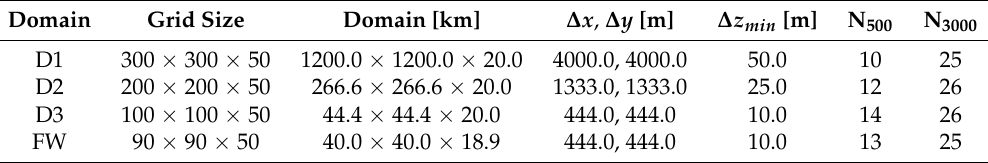
Table 1. ARPS nested grid configurations (domains D1, D2, and D3) and FLEXPART-WRF grid configuration (domain FW), with dimensions (excluding boundary points). ∆ x and ∆ y are the horizontal grid spacing in the west–east and south–north directions, ∆ z min is the vertical grid spacing of the first grid cell above the ground, and N 500 and N 3000 are the number of vertical grid levels within the lowest 500 m and 3000 m of the model atmosphere, respectively (values chosen based on evaluation of simulated mixed layer heights during morning and afternoon). For reference, the lowest model level for scalars and horizontal wind components is one-half of ∆ z min